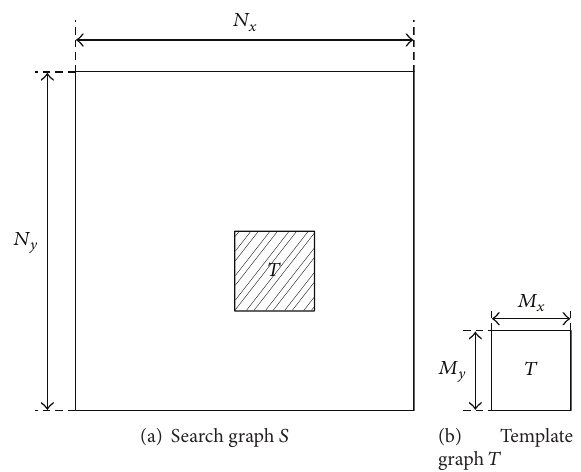
Figure 2: Template and search